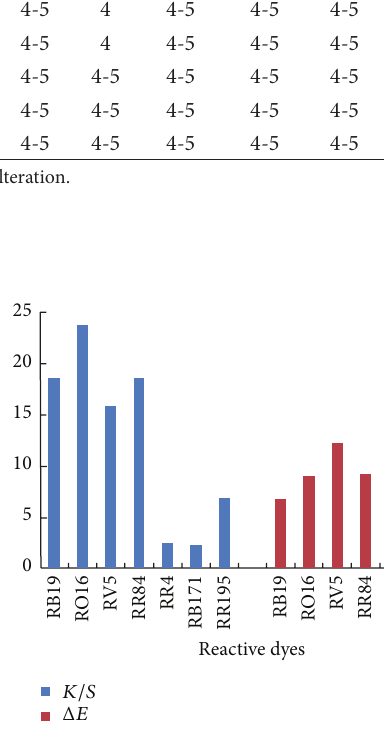
Figure 10: Comparative colour difference and colour strength of different reactive dyes on amidoximated acrylic fabrics; dyeing con- ditions: shade 2% owf, liquor ratio 40: 1, pH 2.5, at 100 ∘ C for 60